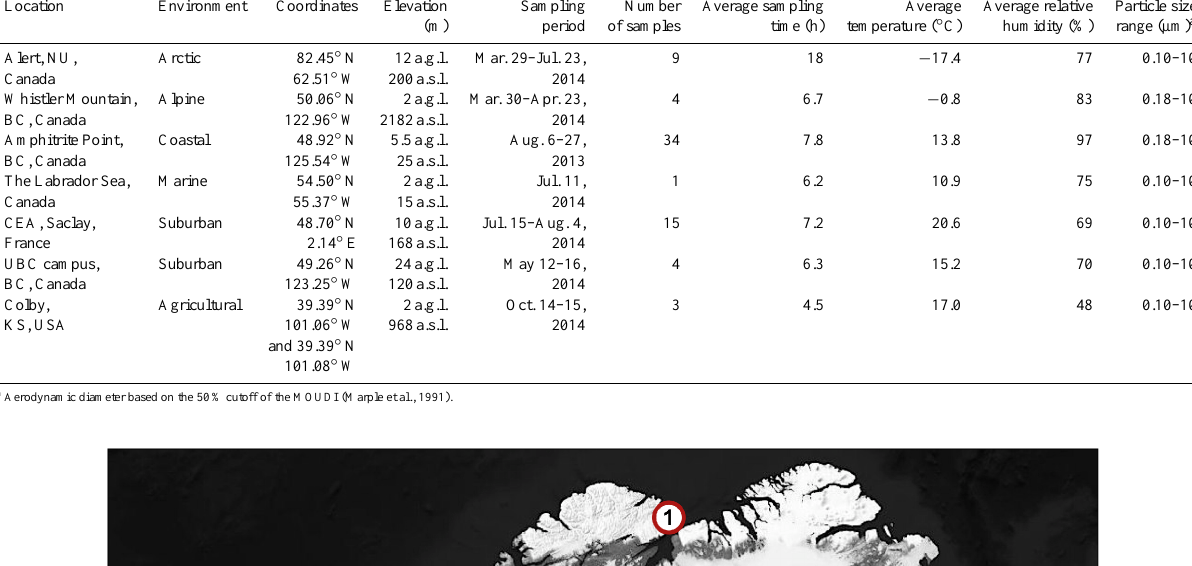
humidity (%) range (µm) a